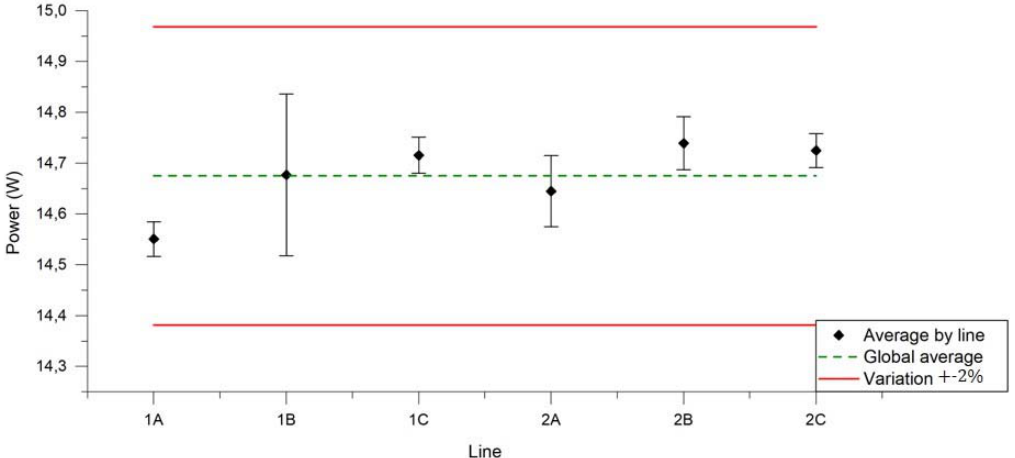
Figure 5. Average power applied from each U-SAV line over 100 puffs during 24 manipulations (dark dots). Red lines represent ±2%. Green line represents the average from all U-SAV lines.